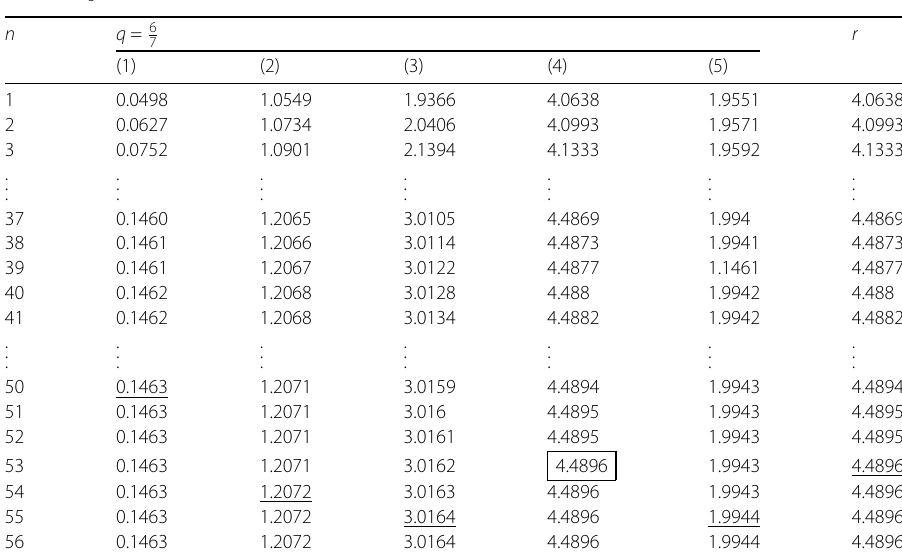
Table 12 Numerical results of (1) = L 1 Λ 1 + | 1 b 0 | and ( i ) = L i Λ i + 2 for q = 7